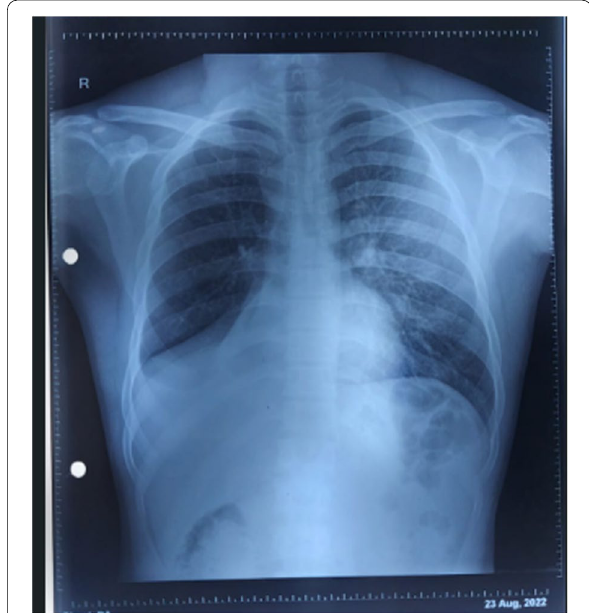
Fig. 1 Pre-operative chest X-ray of patient